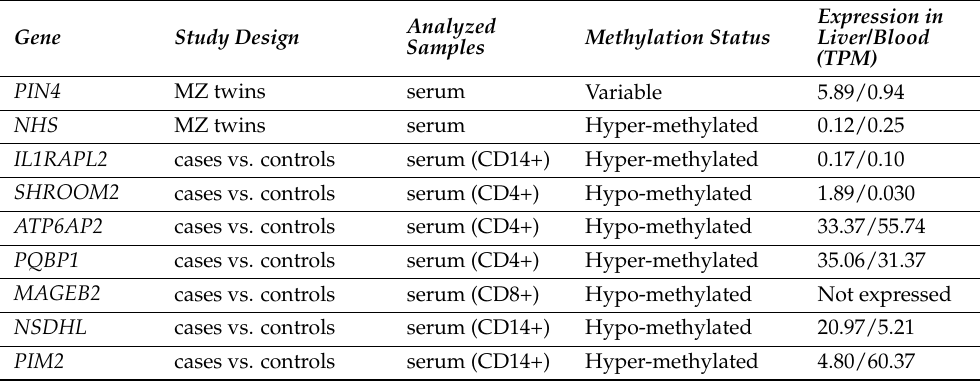
Table 2. Characteristics of differentially methylated genes in PBC showing signals of association with the disease at p < 0.0005. Expression in Analyzed Methylation Status Liver/Blood Gene Study Design Samples (TPM) PIN4 MZ twins serum Variable 5.89/0.94 MZ twins serum Hyper-methylated 0.12/0.25 IL1RAPL2 cases vs. controls serum (CD14+) Hyper-methylated 0.17/0.10 cases vs. controls serum (CD4+) cases vs. controls serum (CD4+) cases vs. controls serum (CD8+) cases vs. controls serum (CD14+) cases vs. controls serum (CD14+)